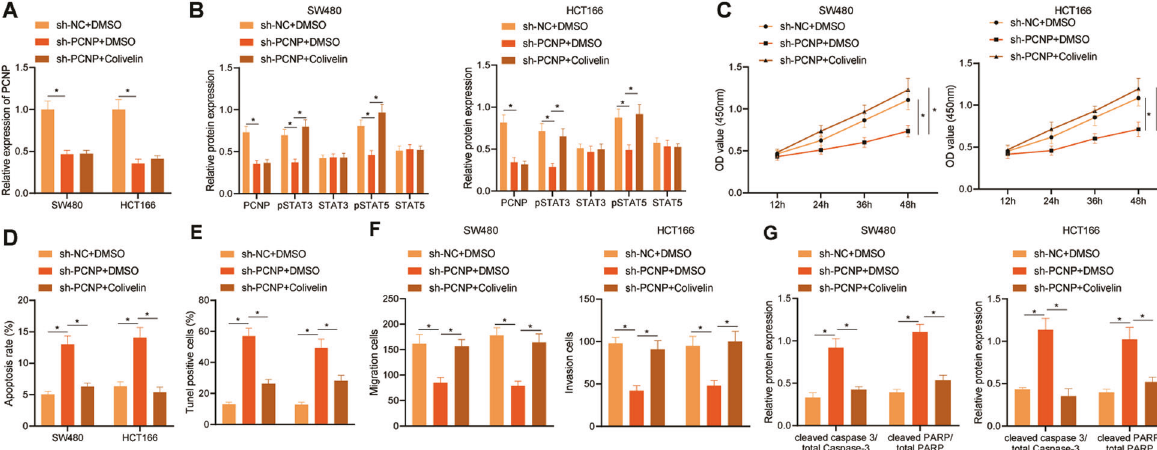
Fig. 5 PCNP activates the STAT3/5 signaling pathway to promote colon cancer cell proliferation, migration and invasion while inhibiting apoptosis. A The expression of PCNP in HCT166 and SW480 cells was determined by RT-qPCR. B The expression of PCNP, STAT3 and STAT5, and phosphorylation levels of STAT3 and STAT5 in HCT166 and SW480 cells detected by Western blot assay. C HCT166 and SW480 cell proliferation assessed by CCK-8 assay. D HCT166 and SW480 cell apoptosis detected by fl ow cytometry. E HCT166 and SW480 cell apoptosis detected by TUNEL staining. F HCT166 and SW480 cell invasion assessed by Transwell assay. G The expression of cleaved caspase-3/total Caspase 3 and cleaved PARP/total PARP in HCT166 and SW480 cells detected by Western blot assay. * p < 0.05. Data from multiple groups were